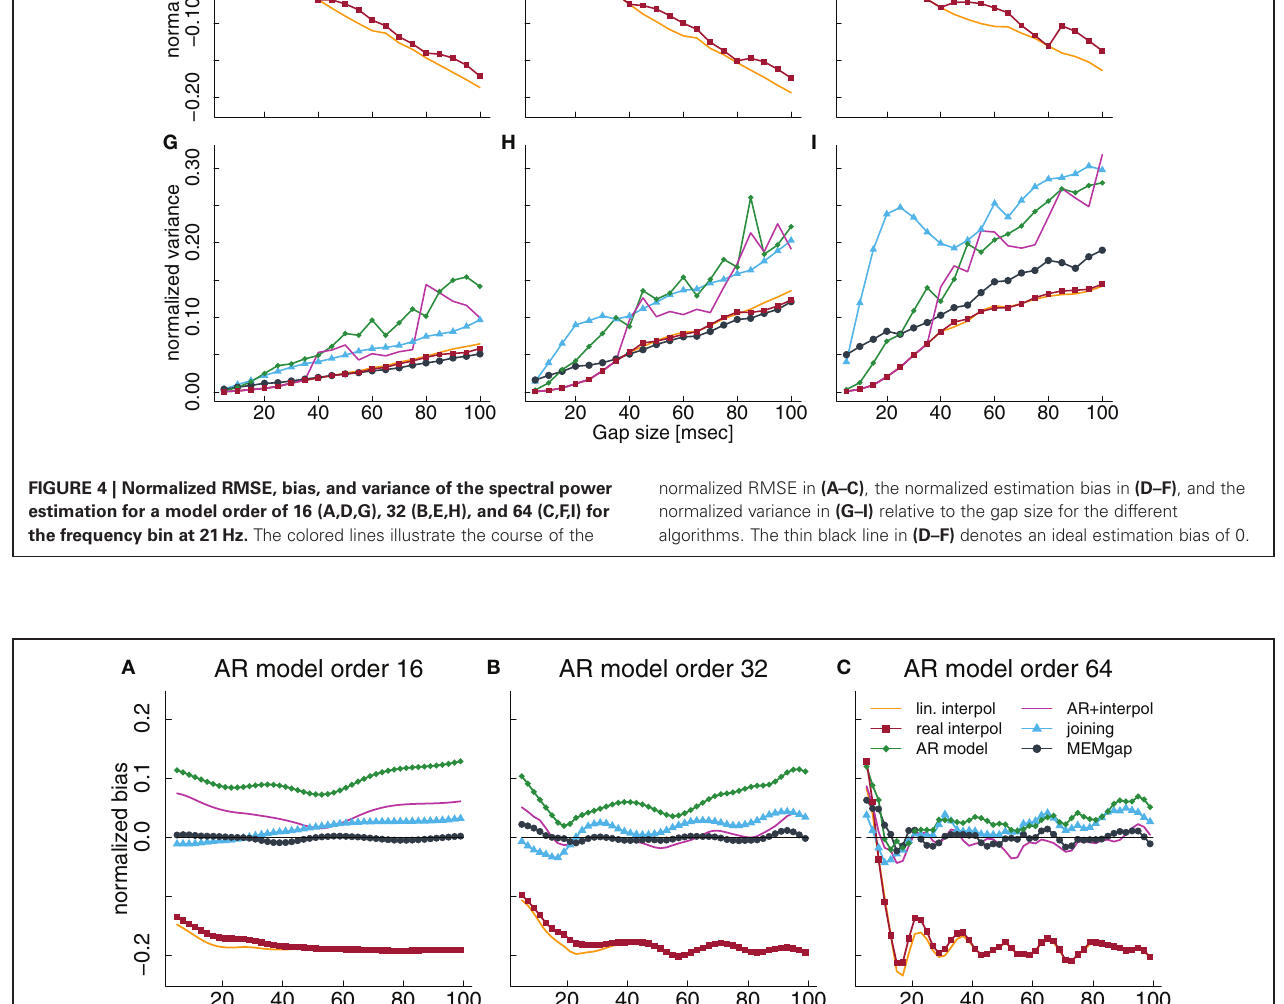
FIGURE 5 | Normalized bias for a gap size of 100ms and an AR model order of 16 (A), 32 (B), and 64 (C) as a fraction of the power of the original signal. The thin solid line always indicates a bias of 0.